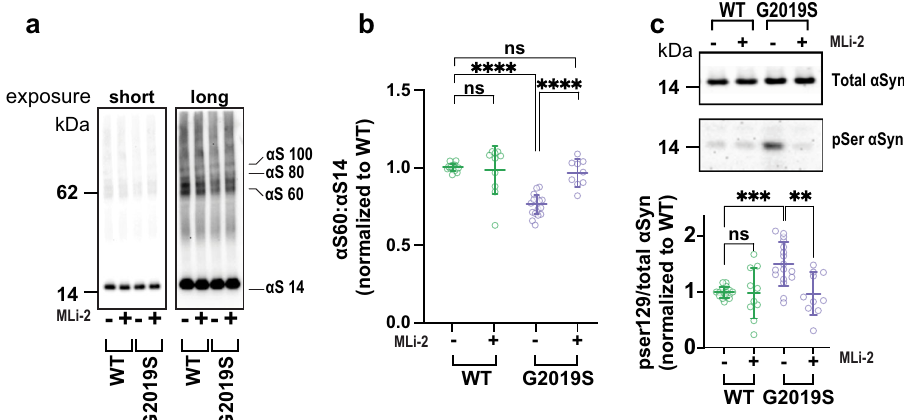
Fig. 3 Decreased tetramer:monomer ratio and increased phosphorylation of α Syn are reverted by LRRK2 kinase inhibition. a Representative WBs of total cell lysates after intact-cell crosslinking following conditioning with ( + ) or without ( − ) MLi-2 inhibitor (0.01 μ M). b Quanti fi cation shows that LRRK2 kinase inhibition restores the lowered α Syn T:M ratio caused by the G2019S mutation. c Quanti fi cation of phosphorylated and total α Syn in mutant vs. corrected neurons with ( + ) and without ( − ) MLi-2 treatment. Inhibiting LRRK2 kinase restores normal α Syn phosphorylation (For both B and C, N ≥ 4 independent experiments; each dot is the average quanti fi cation of an independent six-well plate experiment; one-way ANOVA with Tukey ’ s post hoc test; error bars = SEM; ** p < 0.01, **** p < 0.0001, ns not signi fi